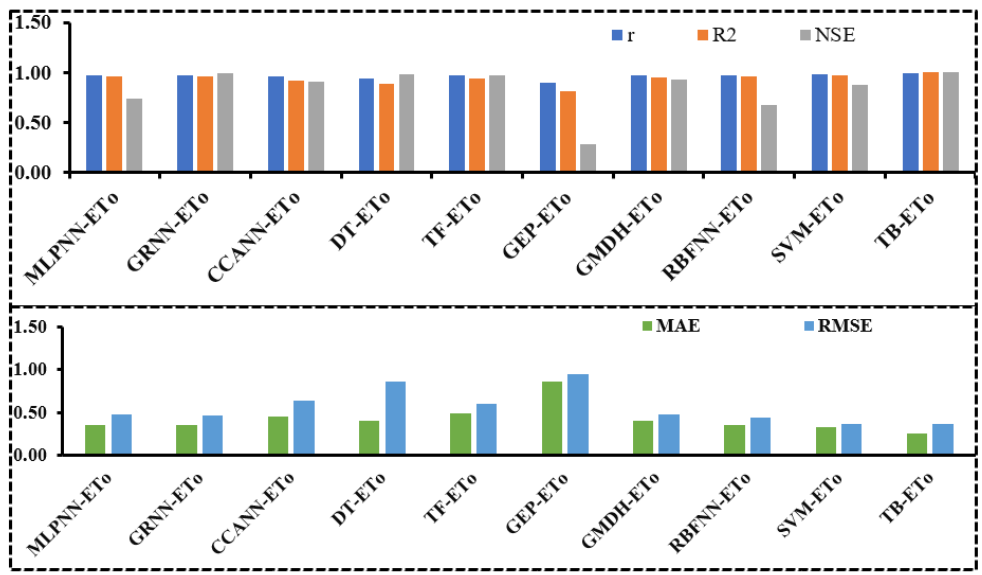
Figure 7. Results of evaluation indices (r, R 2 , NSE, RMSE and MAE) for the applied ML models.